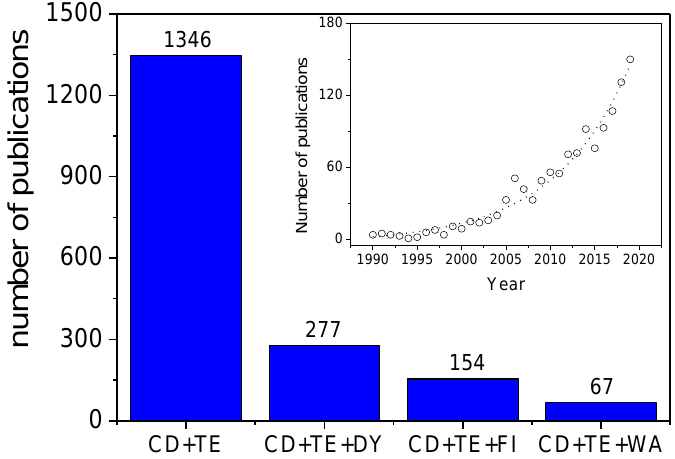
Figure 1. Number of publications available from SCOPUS when cyclodextrin (CD); textile (TE); dyeing (DY); textile finishing (FI); and textile wastewater (WA) are selected as keywords.